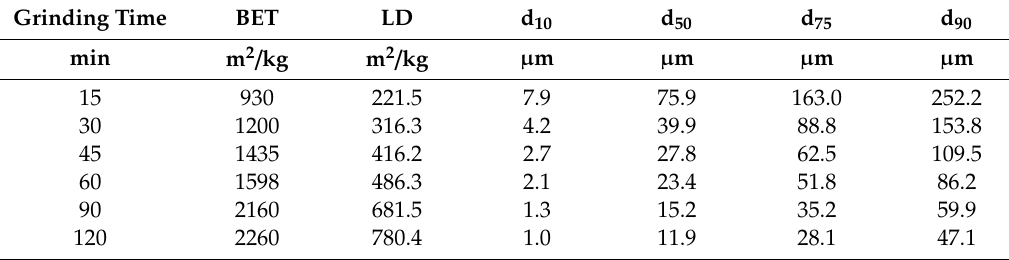
Table 4. Equivalent particle size and specific surface area of slag grinding products at different times.